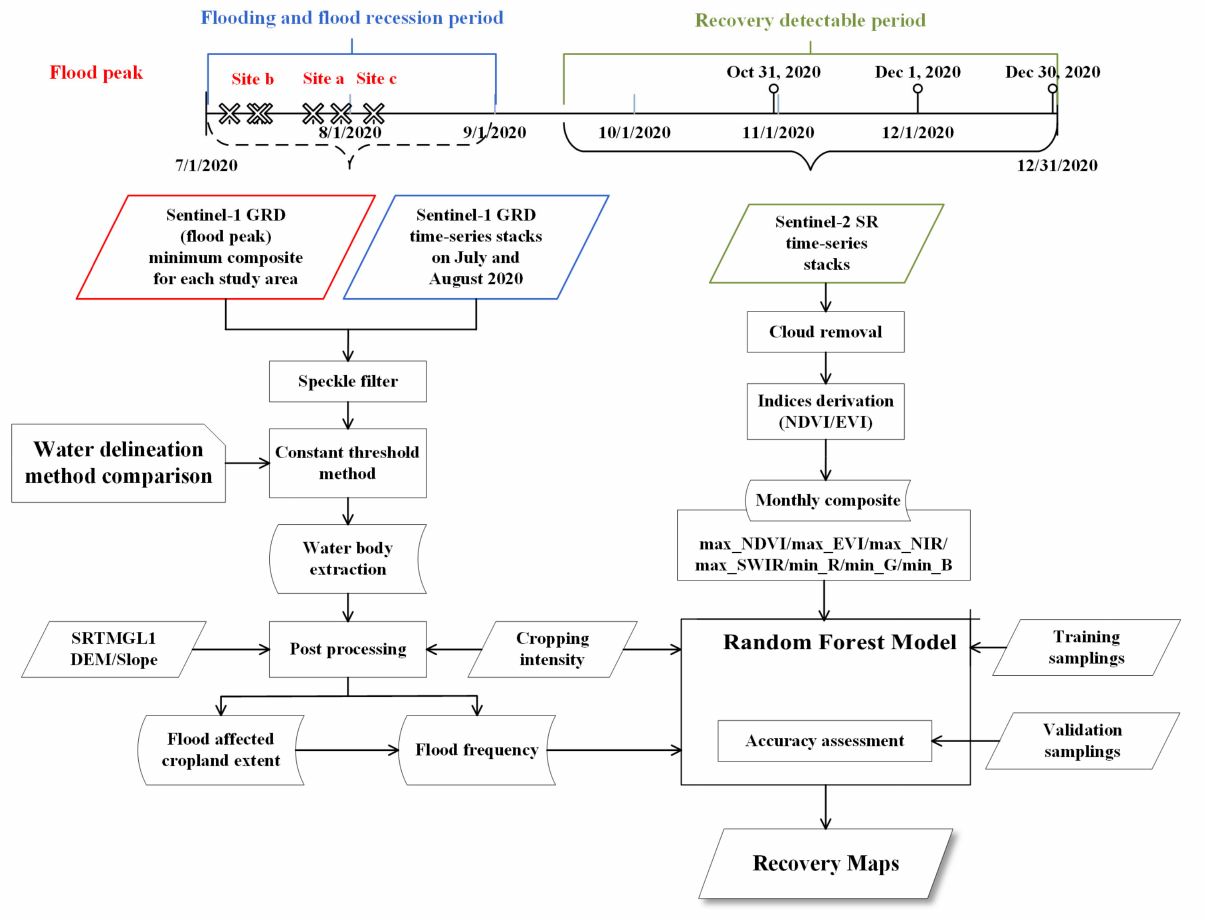
Figure 3. Flowchart of the